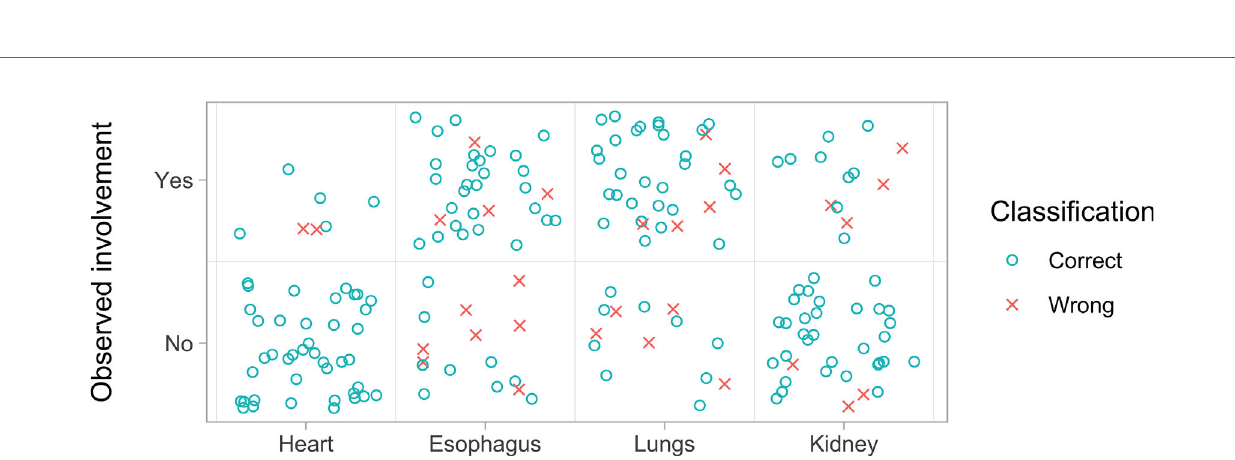
FIGURE 4 | Overview of the prediction model goodness of fi t by organ involvement. For each organ investigated are represented the correct (blue circle) and wrong predictions (red x). The data refer to those reported in Table 4 . For the heart, the model correctly predicted the absence of involvement in all 41 patients and the presence of involvement in seven patients, failing only two cases. For the esophagus, the model predicted the absence of complication in 16 patients and was wrong in seven cases, while it predicted the absence of involvement in 32 cases but was wrong four times. For the lung, the model predicted the absence of involvement in 14 cases and was wrong fi ve times while it predicted the presence of involvement in 34 patients and was wrong fi ve times. Finally, for the kidney, the model predicted the absence of involvement in 35 patients and was wrong three times while it predicted the presence of involvement in 13 patients and was wrong four